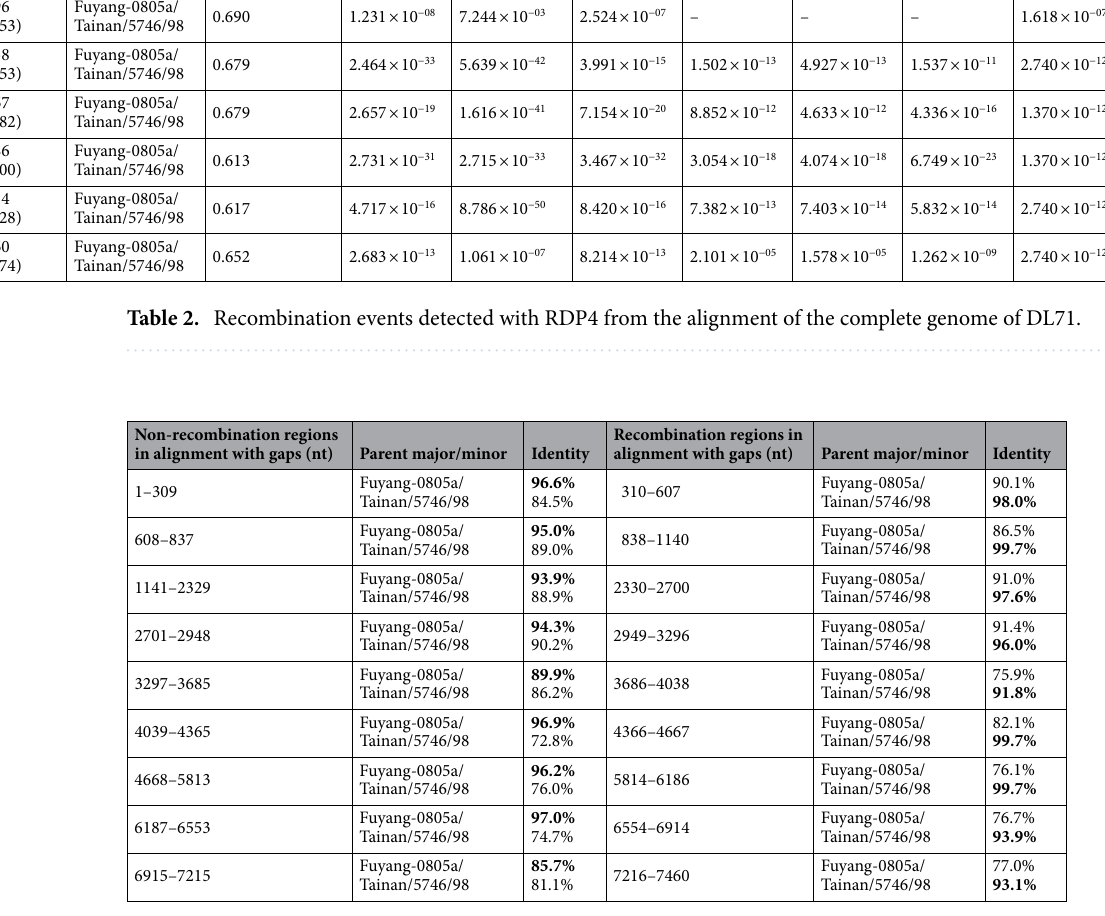
Table 3. Nucleotide sequence identities of the non-recombination and recombination regions between DL71 and its putative parental strains. The highest nucleotide identities of different regions are marked in bold.